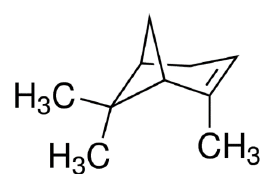
Table 1. Overview of B. bassiana ARSEF 8465 Biological Index Interactions.